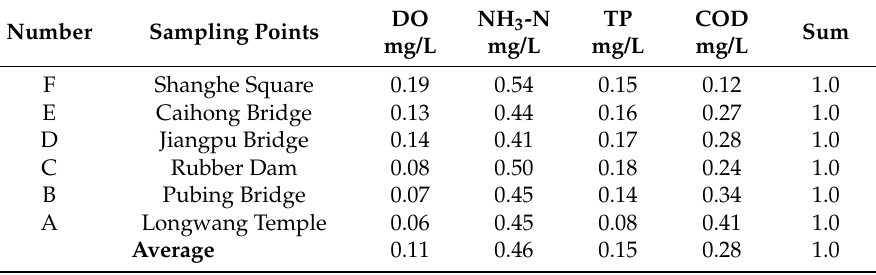
Table 8. The calculation results of weight coefficient of six sections before